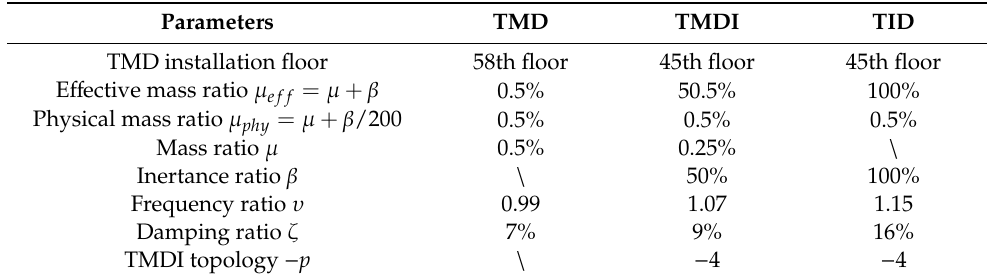
Table 3. Design parameters of Tuned Mass Damper (TMD), Tuned Mass-Damper-Inerter (TMDI) and Tuned Inerter Damper (TID) used for the comparative study.